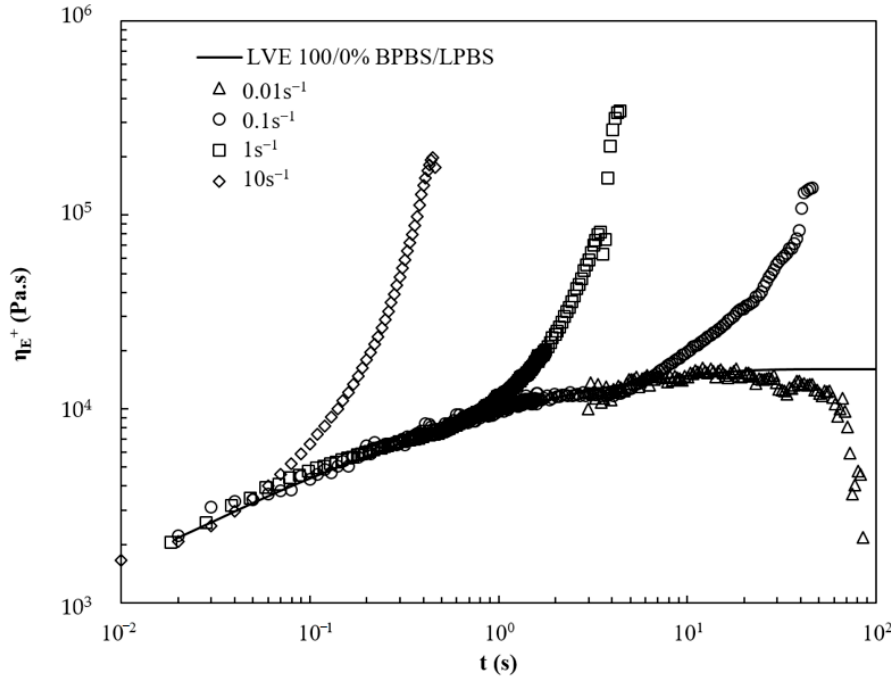
Figure 9. Viscosity curves under extensional flow at various strain rates for BPBS at 150 °C. The 50/50% BPBS/LPBS blend in Figure 10 shows close behavior to that of LPBS. At the lower rate, it shows a linear response but exhibits strain softening at intermediate rate. At 𝜀 = 10 s − 1 , a slight strain hardening is observed.